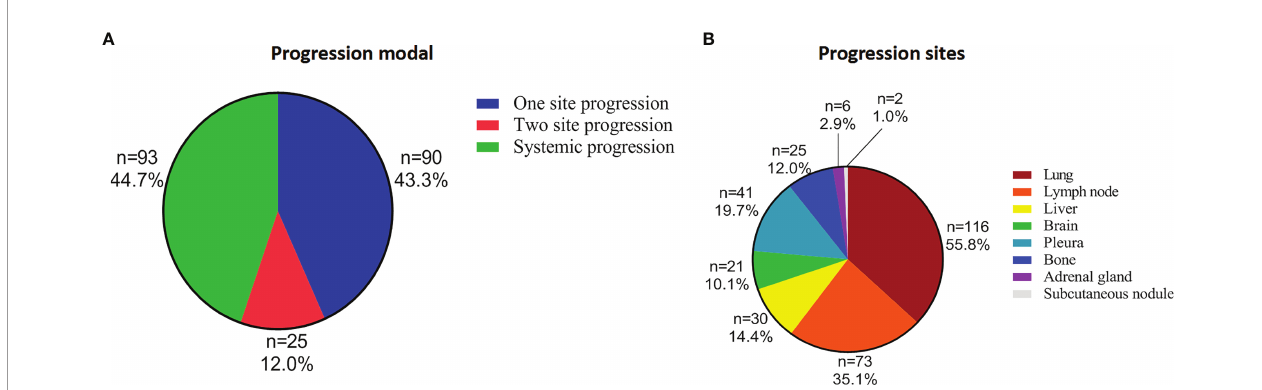
FIGURE 2 | Progression patterns and sites beyond immunotherapy resistance. (A) 115 (55.3%) patients developed oligoprogression, and 93 (44.7%) developed systemic progression. Ninety (90/208, 43.3%) patients developed progressive disease at one site. (B) The progression sites included the lung (N = 116, 55.8%), lymph node (N = 73, 35.1%), liver (N = 30, 14.4%), brain (N = 21, 10.1%), pleura (N = 41.19.7%), bone (N = 25, 12%), adrenal gland (N = 6, 2.9%), and subcutaneous nodule (N =